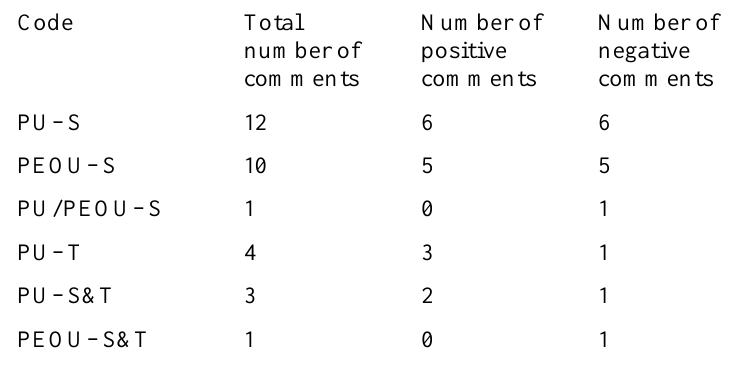
Coding of Comments from